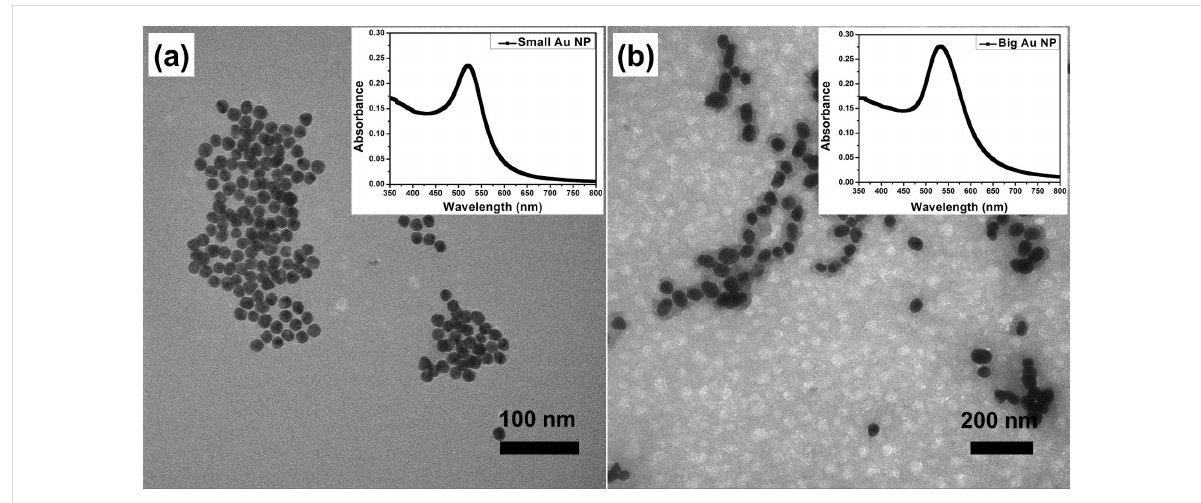
Figure 1: TEM images of the obtained Au NPs: (a) small Au NP, (b) big Au NP. The insets show the UV–vis spectra of the corresponding Au NP solutions.